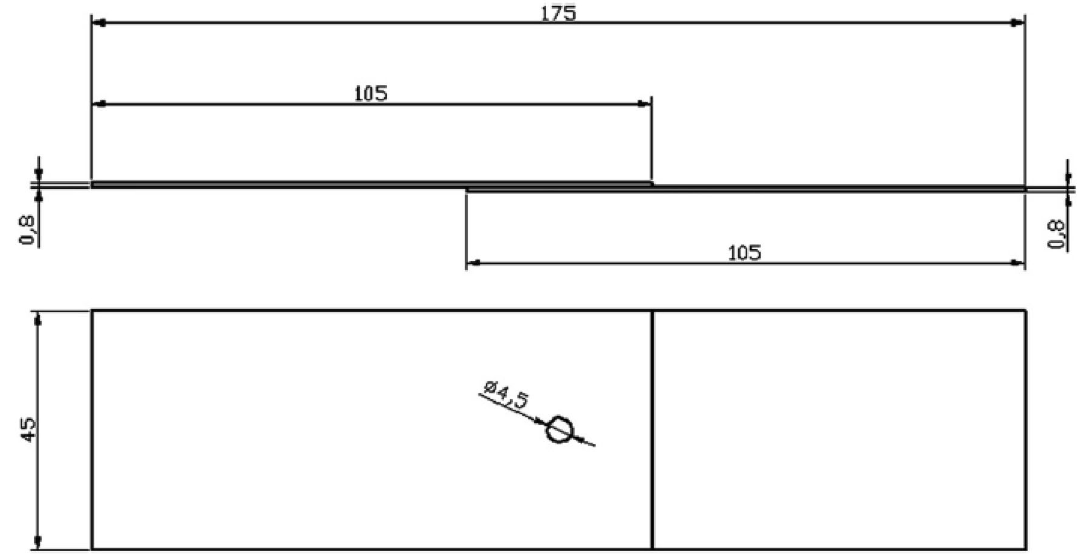
Figure 1. Dimensions of spot-welded tensile shear test specimens